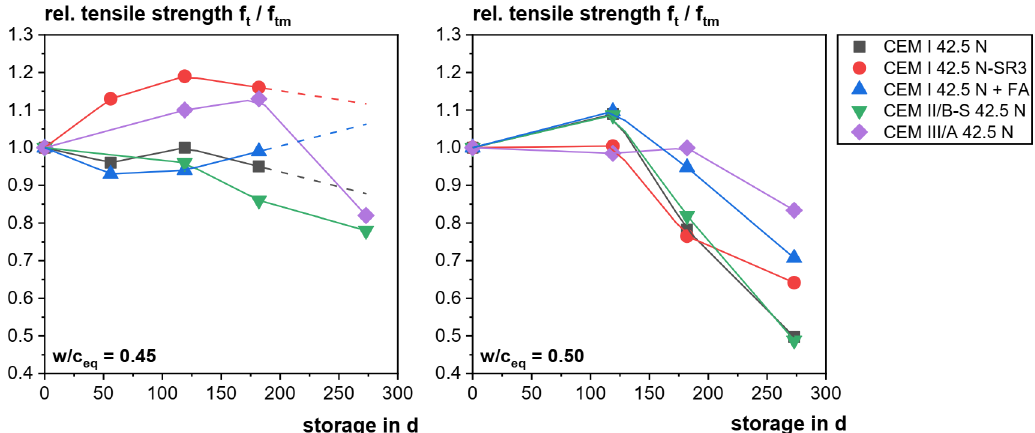
Figure 9. Relative tensile strength (ref.: maturity function) of the concretes with w/c eq = 0.45 and w/c eq = 0.50 after storage in Na 2 SO 4 solution with 6000 mg SO 42 − /L at 5 ◦ C (dashed lines: extrapolated